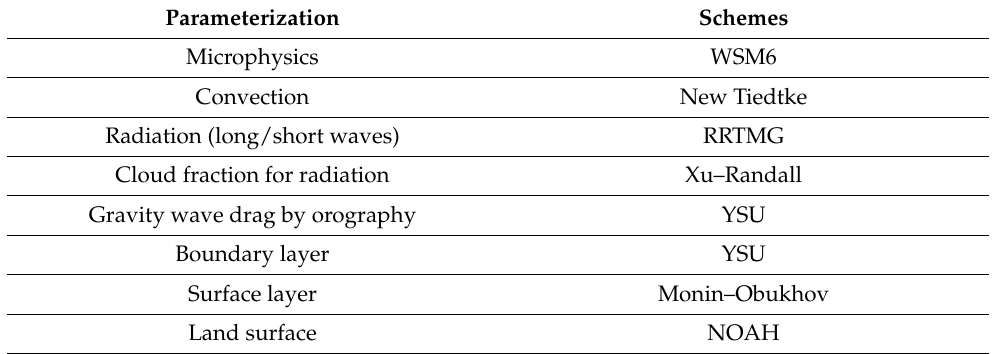
Table 1. Parameterization schemes of “mesoscale_reference” in MPAS.